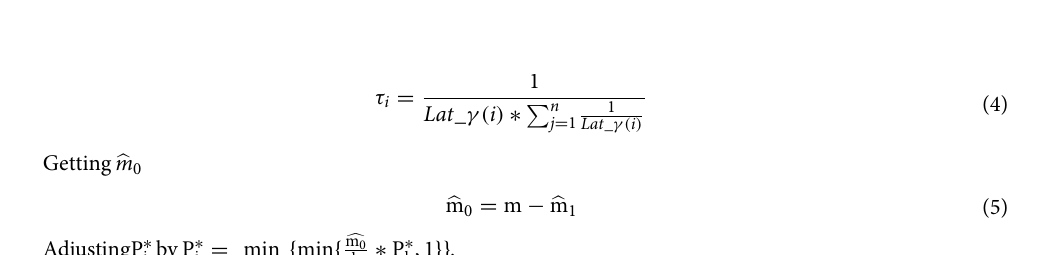
Table 2. Basic information of three NPC